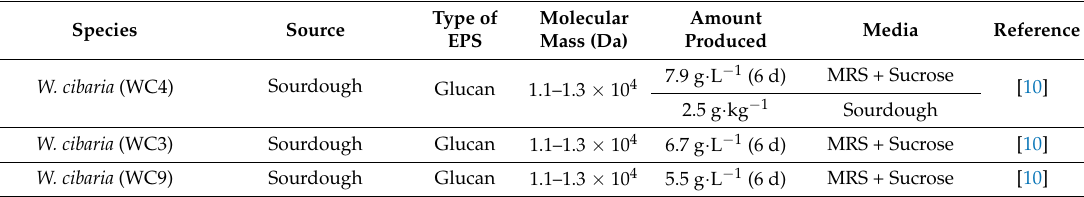
Table 5. Characterization of EPS from Weissella